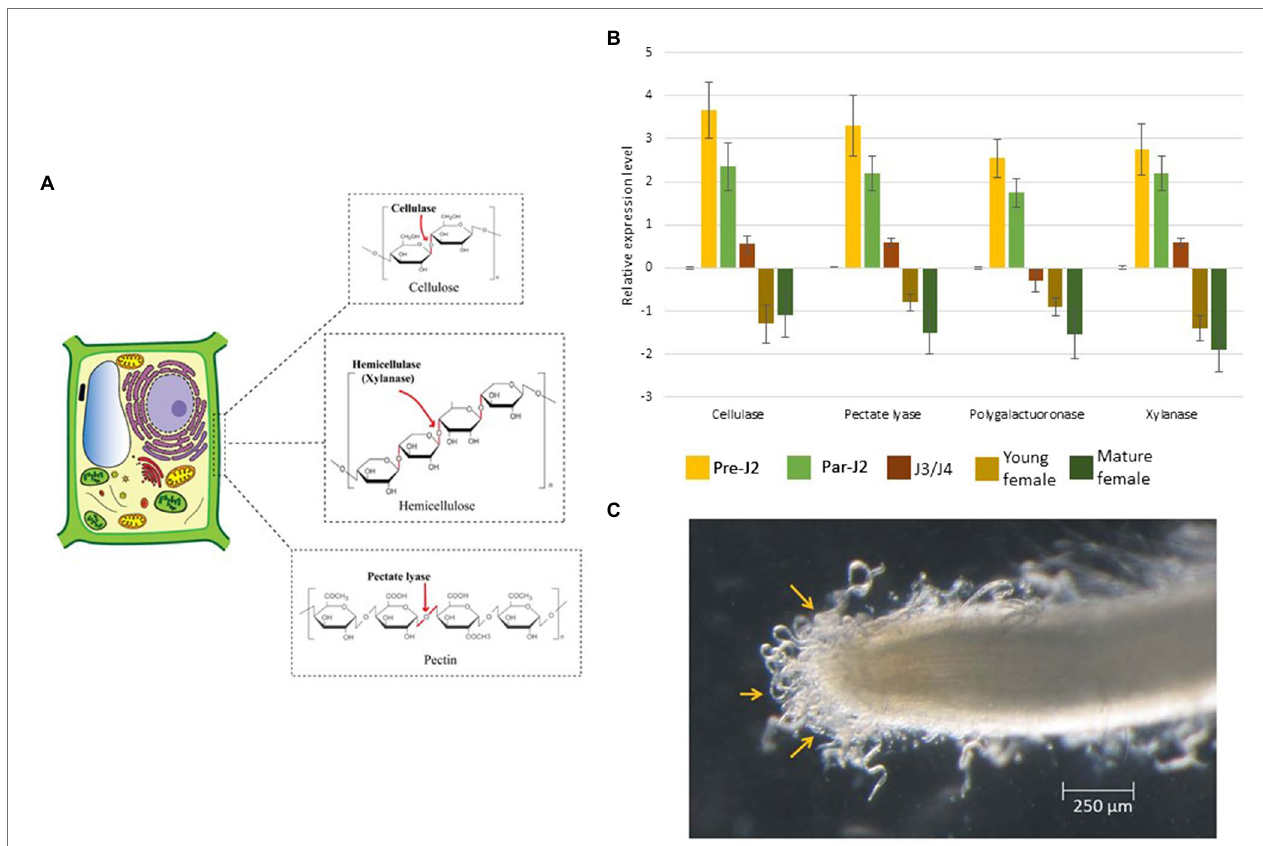
FIGURE 3 | Molecular effects of CWDEs. (A) Pre-parasitic juveniles produce a cocktail of CWDEs in the SvGs. Cellulases act on cellulose, the major backbone of the plant cell wall. Xylanase cleaves hemicellulose. Pectate lyase acts on pectin which weakens the cell wall. (B) The real-time expression profile of CWDEs shows maximum expression during pre-parasitic J2s which reduces with RKN development. The expression data is derived from (Shivakumara et al., 2017). About 400 ng RNA was used to prepare cDNA. The transcript level in all the stages was compared with that in eggs. Expression level was quantified using 2 −ΔΔ Ct method. 18S rRNA was used as a reference gene. (C) Pre-parasitic juveniles latched to the root surface prior to entering the root. The RNAseq analysis of pre-parasitic J2s at this stage in different host plants could reveal the CWDE isoform expression dynamics. The image is reproduced from (Shivakumara et al., 2017) with permission from the corresponding